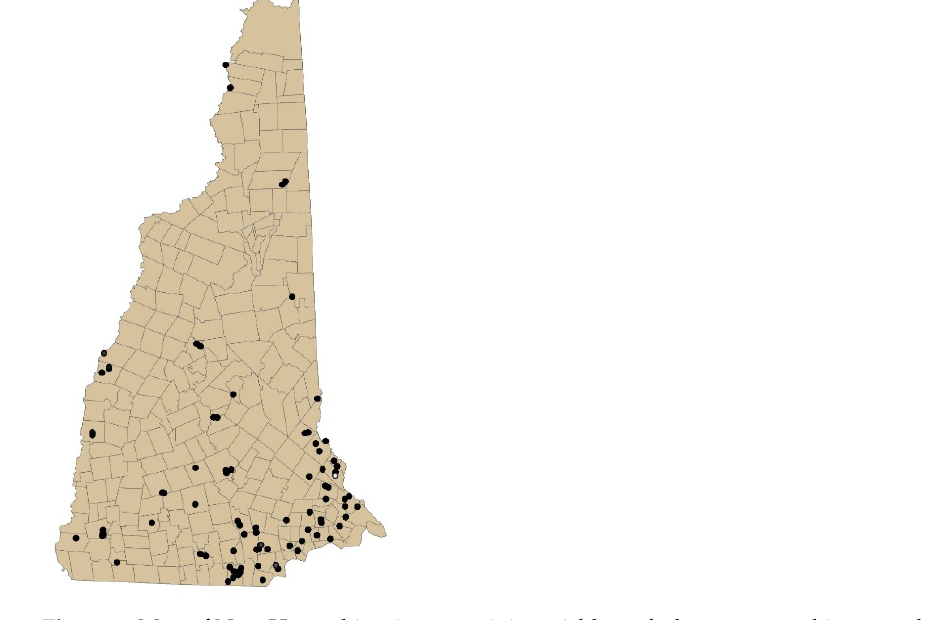
Figure 1. Map of New Hampshire sites containing trichloroethylene measured in groundwater.